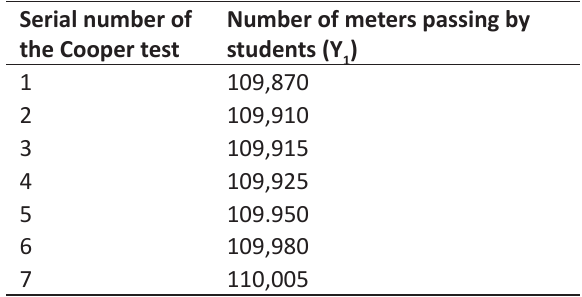
Table 1. Results of the Cooper test for the control group Serial number of